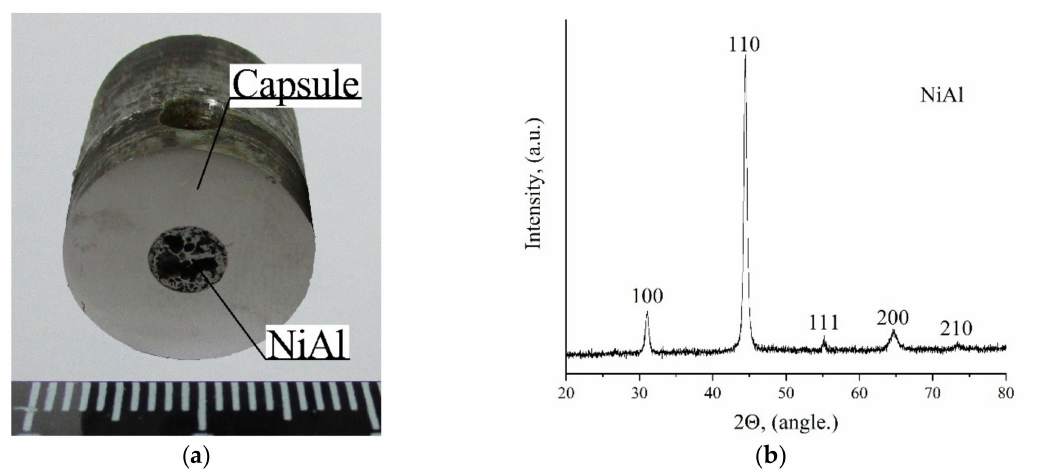
Figure 12. ( a ) Photograph of segment III (ampoule No.1); ( b ) XRD pattern of NiAl powder after